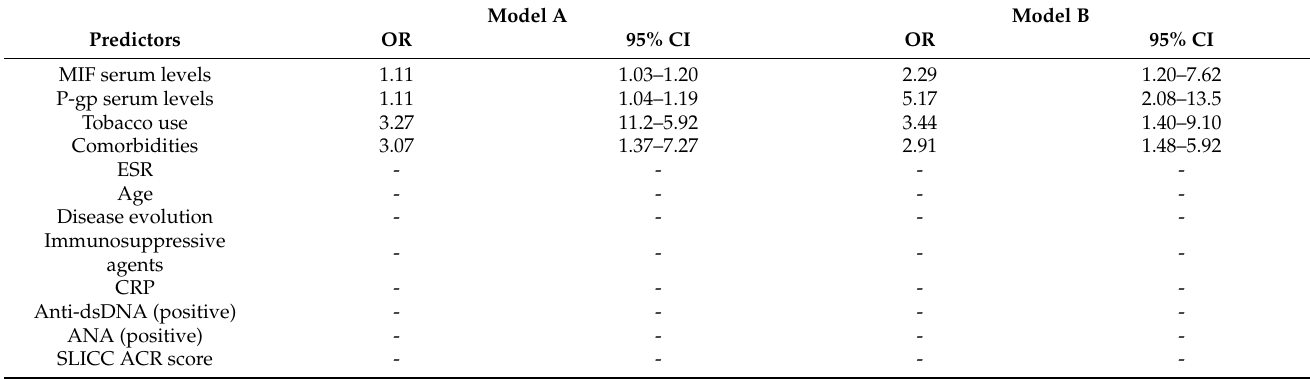
Table 4. Factors associated with steroid resistance in SLE.